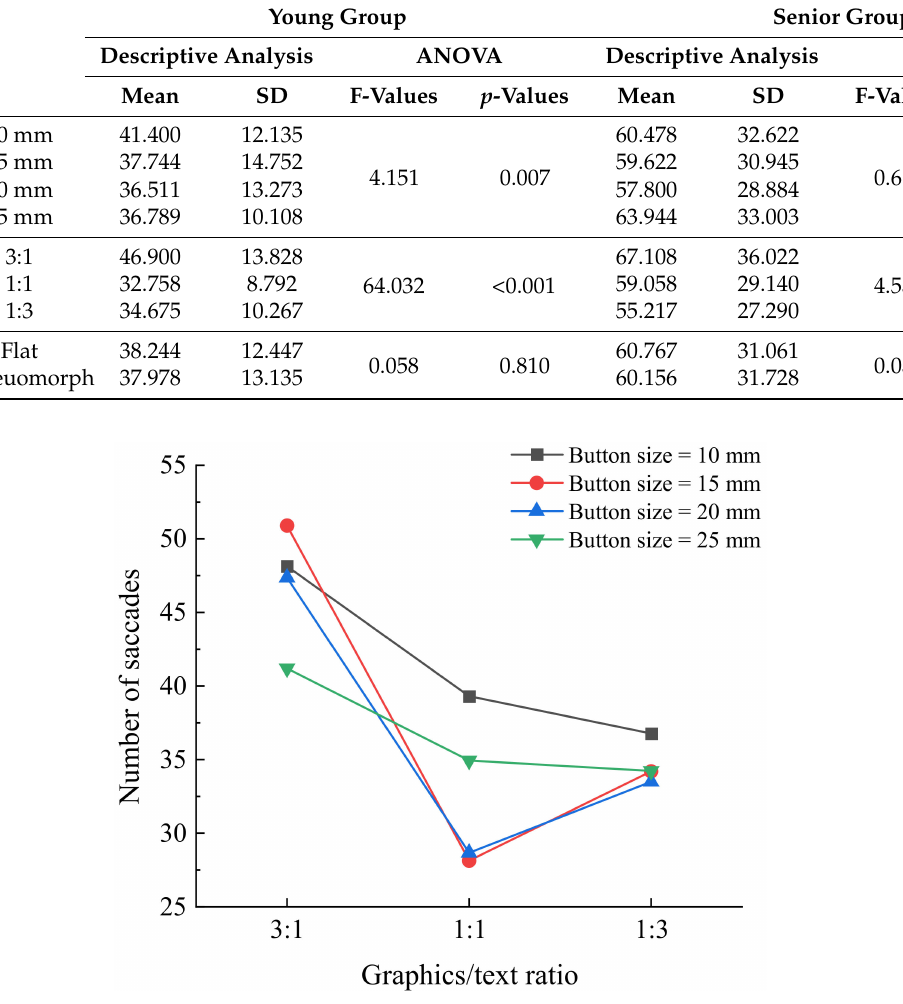
Figure 3. Number of saccades by graphics/text ratio and button size for young